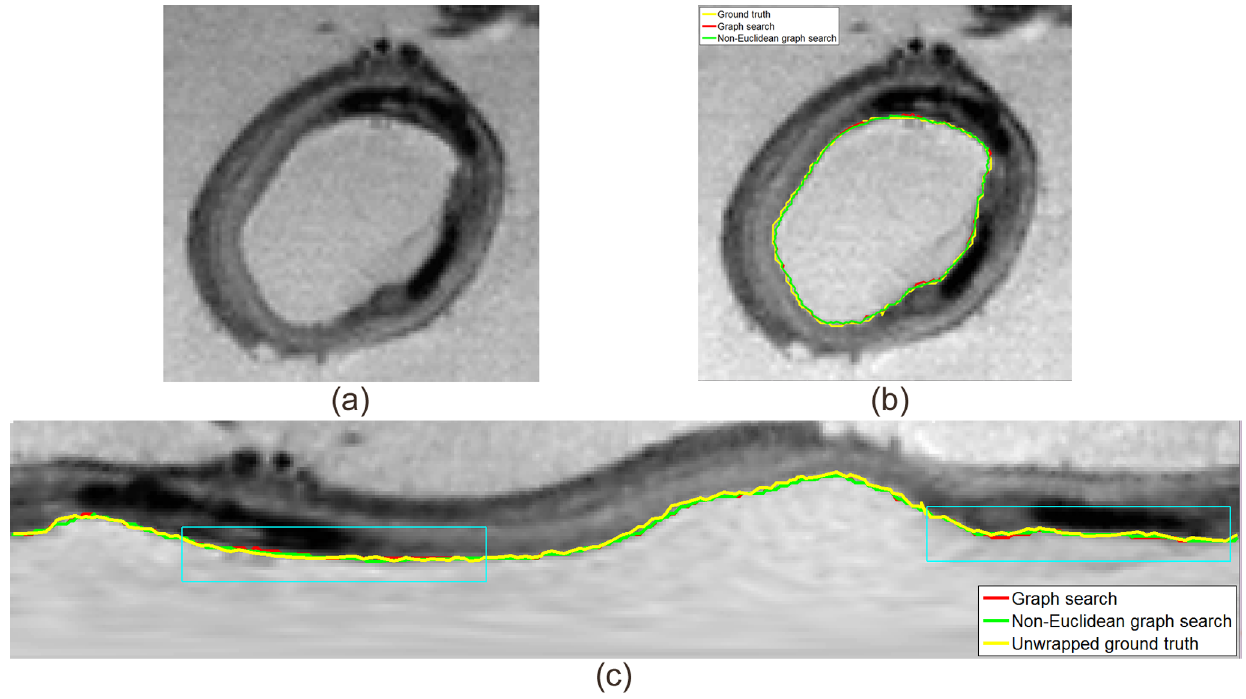
Figure 16. One slice of vascular wall segmentation by conventional graph search and non-Euclidean graph search. (a) Original slice; (b) Segmentation results; (c) Unwrapped slice. Result from the conventional graph search is shown in red, the non-Euclidean graph search in green and the ground truth in yellow. doi:10.1371/journal.pone.0107763.g016 order and plotted in Fig. 15 for comparison. Non-Euclidean graph search reduces the percentage of A-scans with an error larger than 0.5 voxel from 27.25% to 3.14% compared to the conventional graph search method.